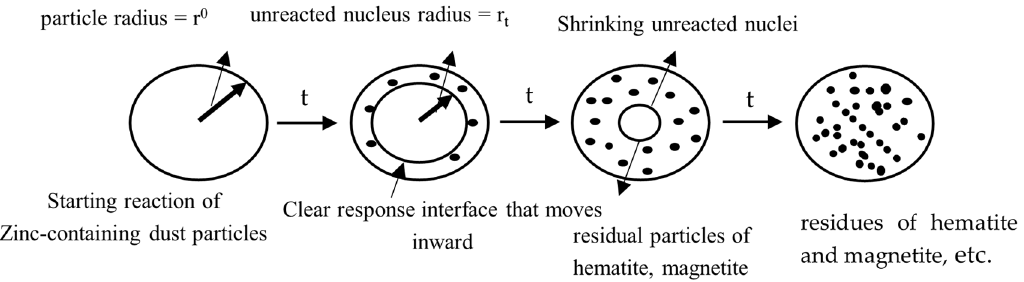
Figure 7. Schematic diagram of the leaching process of zinc-containing dust sludge particles.